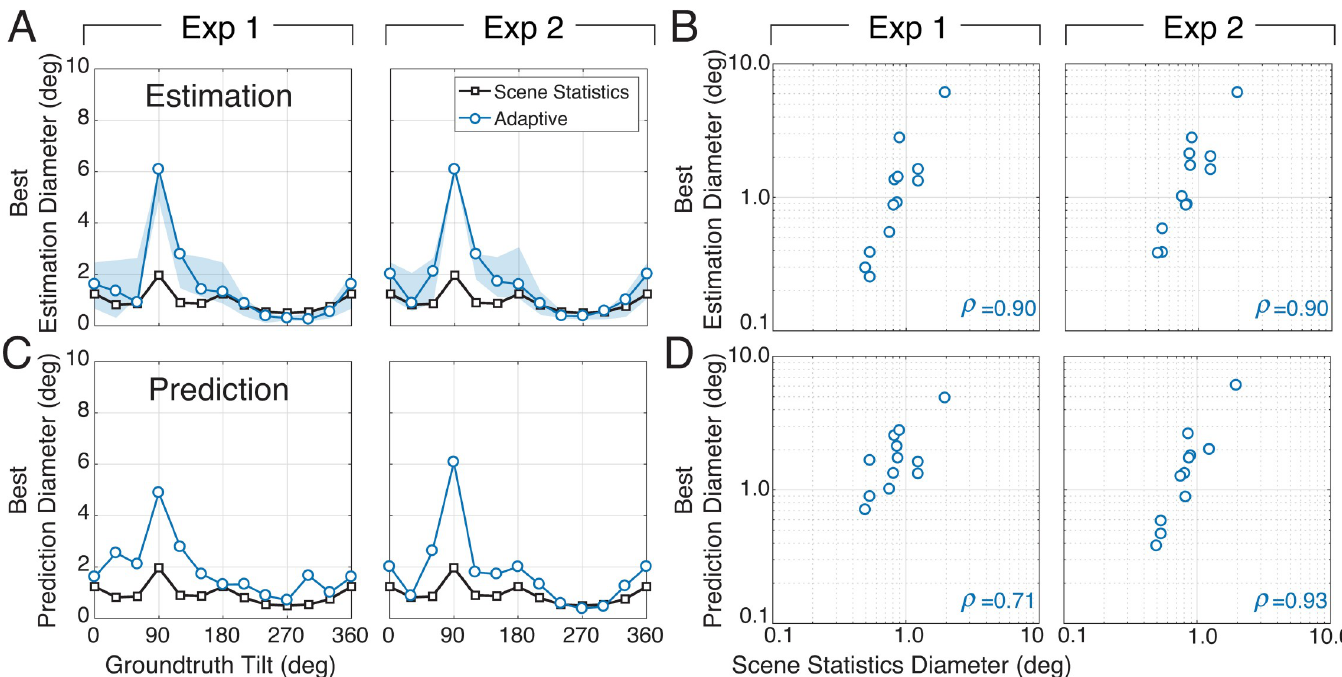
Fig 11. Pooling sizes from natural scene statistics vs. pooling sizes that maximize estimation and prediction performance. Adaptive pooling regions predicted by natural scene statistics predict the pooling regions that independently maximize performance at each groundtruth tilt. A Equivalent pooling diameters fit to the natural scene statistics (black; same data as Fig 9B) and equivalent pooling diameters that minimize estimation error are plotted as a function of groundtruth tilt. The left and right columns represent data from Exp 1 and Exp 2, respectively. B Best estimation diameters are correlated with the diameters fit to the natural scene statistics. C Equivalent pooling diameters fit to the natural scene statistics (black) and equivalent pooling diameters that minimize prediction error (blue), plotted as a function of groundtruth tilt. D Best prediction diameters are correlated with the diameters fit to the natural scene statistics. All correlations were significant at the level of p < 0.05; all but one were significant at the level of p <